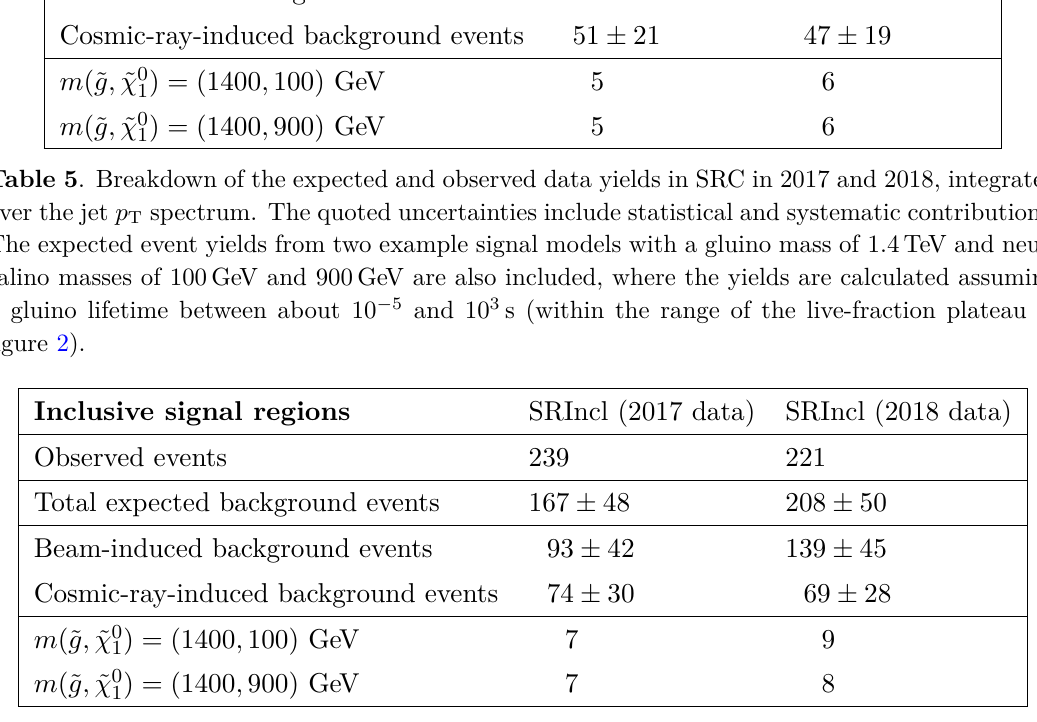
Table 6 . Breakdown of the expected and observed data yields in SRIncl in 2017 and 2018, in- tegrated over the jet p spectrum. The quoted uncertainties include statistical and systematic T contributions. The expected event yields from two example signal models with a gluino mass of 1 . 4 TeV and neutralino masses of 100 GeV and 900 GeV are also included, where the yields are calcu- lated assuming a gluino lifetime between about 10 − 5 and 10 3 s (within the range of the live-fraction plateau in figure